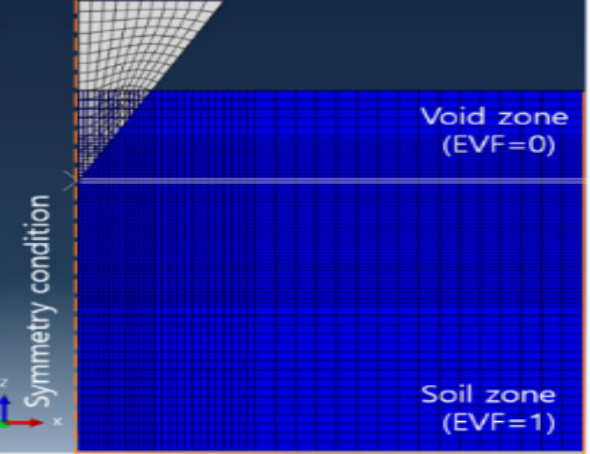
Figure 7. Coupled Eulerian–Lagrangian (CEL) model illustrating the mesh topography.